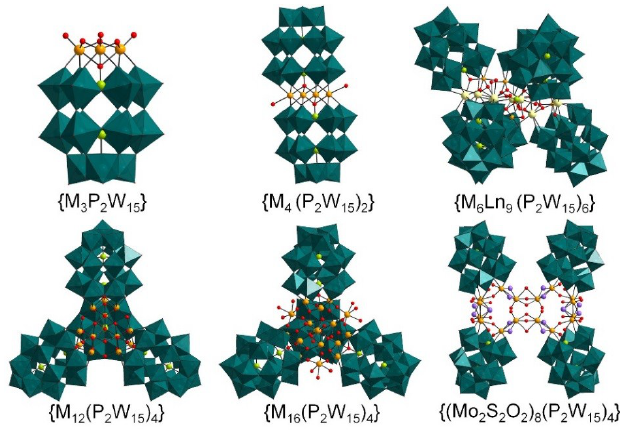
Figure 5. Representation of the transition metal substituted POM structures derived from the {P 2 W 15 }